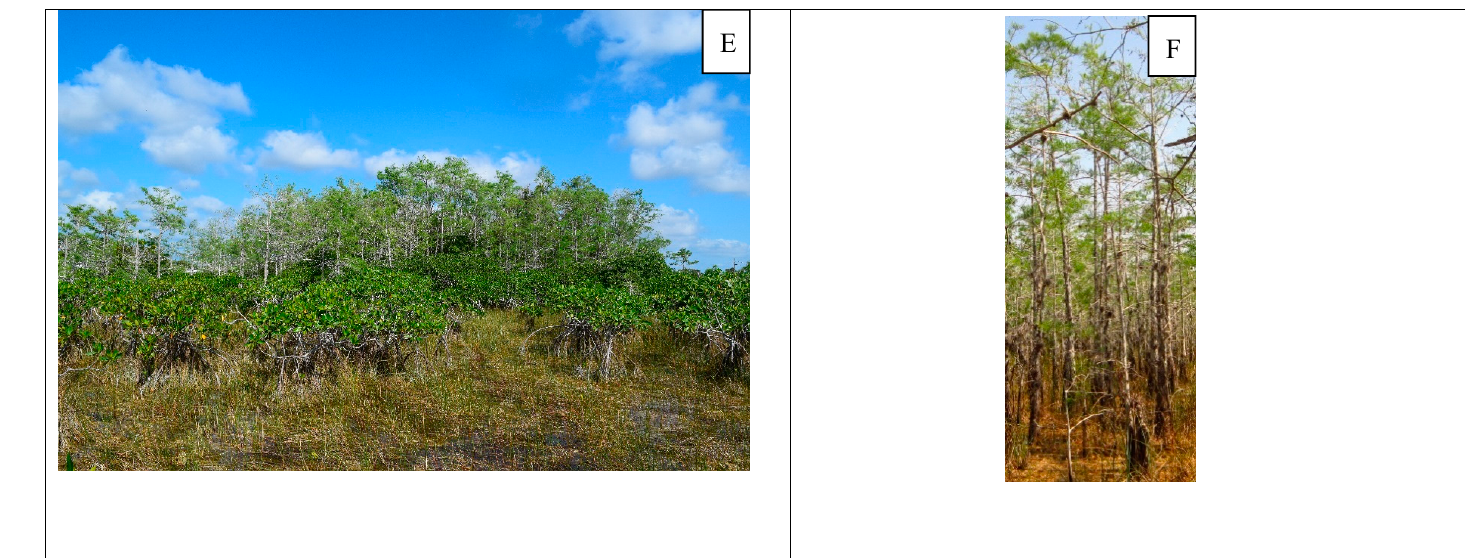
Figure 1. Examples of subtropical wetland ecosystems ( left column ) and the associated foundation species ( right column ). ( A ) Microbial (periphyton) mats in the ridge and slough landscape of the Florida Everglades (photo by Franco Tobias). ( B ) Scanning electron micrograph of Mastogloia calcarea , a diatom foundation species in microbial mats restricted to the South Florida and Caribbean regions (photo by Sylvia Lee from a sample collected in Shark River Slough, Everglades National Park; scale bar: 10 µm [35]). ( C ) Sawgrass-dominated ridge and slough landscape in the Everglades (photo by Luca Marazzi). ( D ) Sawgrass in the Everglades (photo by staff at Florida International University (FIU)’s Geographical Information System Lab). ( E ) Bald cypress dome (in the background) in the Florida Everglades with visible encroachment of scrub mangroves (in the foreground) due to propagule seeding by the 1960 Hurricane Donna and saltwater intrusion caused by sea level rise (photo by Luca Marazzi). ( F ) Bald cypress trees in Everglades National Park (photo by staff at FIU’s South Florida Terrestrial Ecology Lab).